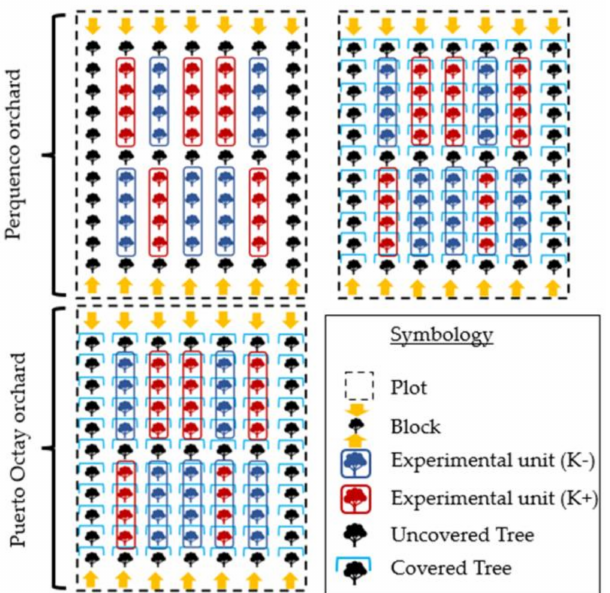
Figure 5. Experimental design of the field study performed in two sweet cherry commercial orchards located at different localities of southern Chile: Perquenco and Puerto Octay. Two foliar potassium (K) treatments were applied: conventional K regime (4 sprays during the season: K − treatment) or intensive K regime (7 sprays during the season: K+ treatment). In each location, the assays were conducted in two consecutive seasons. In the Perquenco orchard, covered and un-covered trees were